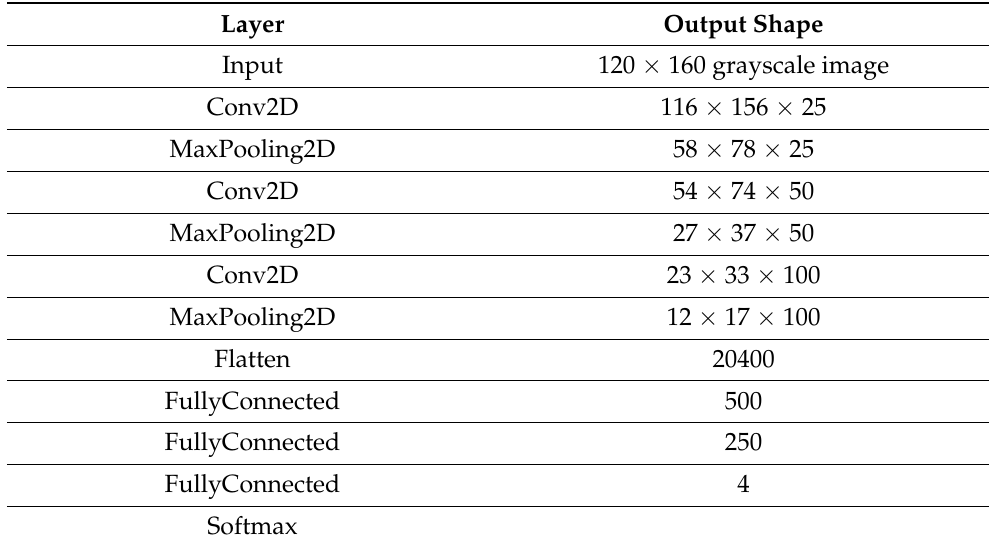
Table 2. The architecture of the CNN